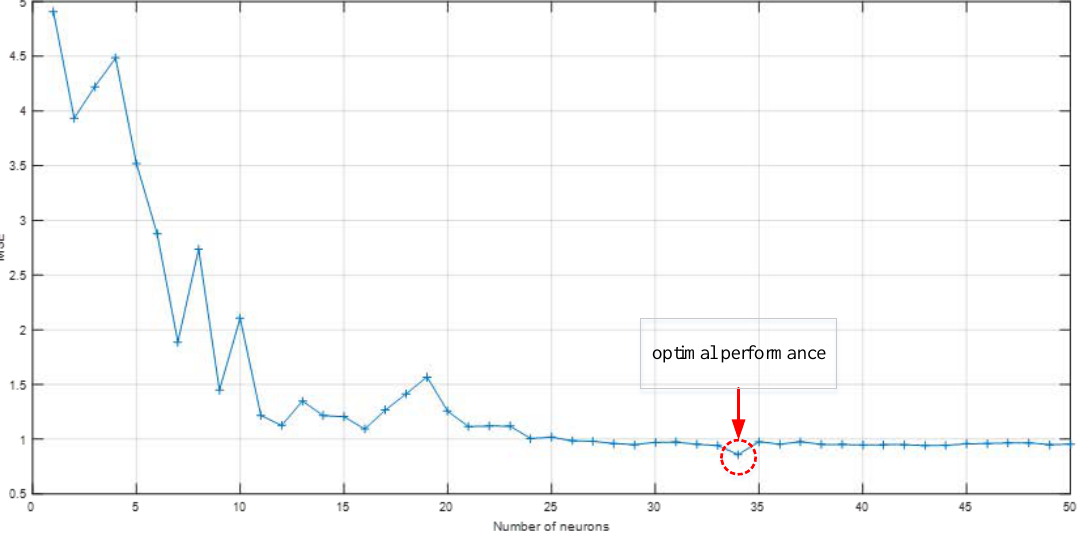
Figure 7. The trial and error results of the DBN model.